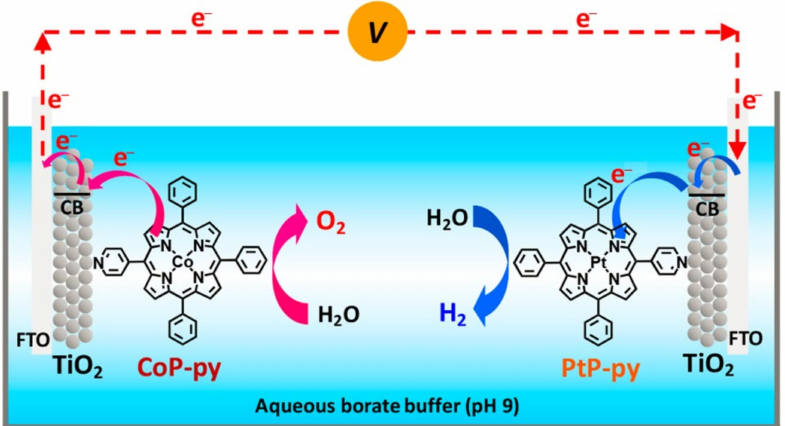
Figure 3. Chemical structures of noncovalently surface-immobilized porphyrin-based small molecules for heterogeneously electrochemical OER. Reproduced from ref. [47,49,51,52].